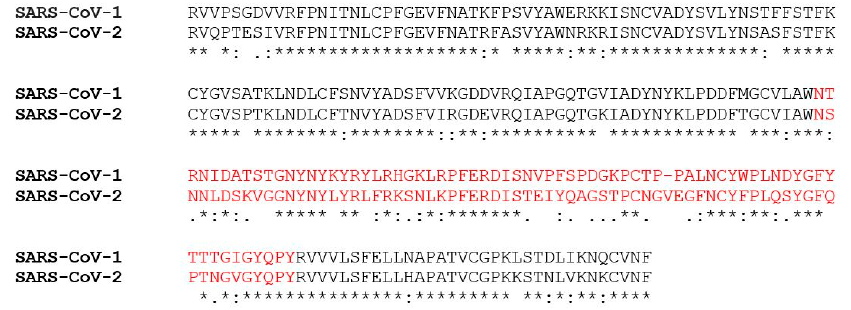
Figure 5. Pairwise amino acid sequence alignment of the receptor binding domain (RBD) of SARS-CoV-1 (Uniprot ID: P59594) and SARS-CoV-2 (Uniprot ID: P0DTC2) performed using Clustal Omega [44]. The asterisk * denotes positions with a single, fully conserved residue. The colon: denotes positions with conservation of groups of strongly similar properties. The period denotes conservation of groups of weakly similar properties. The region labelled in red denotes the receptor binding motif (RBM). RBD of SARS ‐ CoV ‐ 1 and SARS ‐ CoV ‐ 2 share a 73% identity while their RBMs share only a 50% identity. The amino acid substitutions in the RBM of SARS ‐ CoV ‐ 2 result in a greater number of residues interacting with the host cell surface receptor.